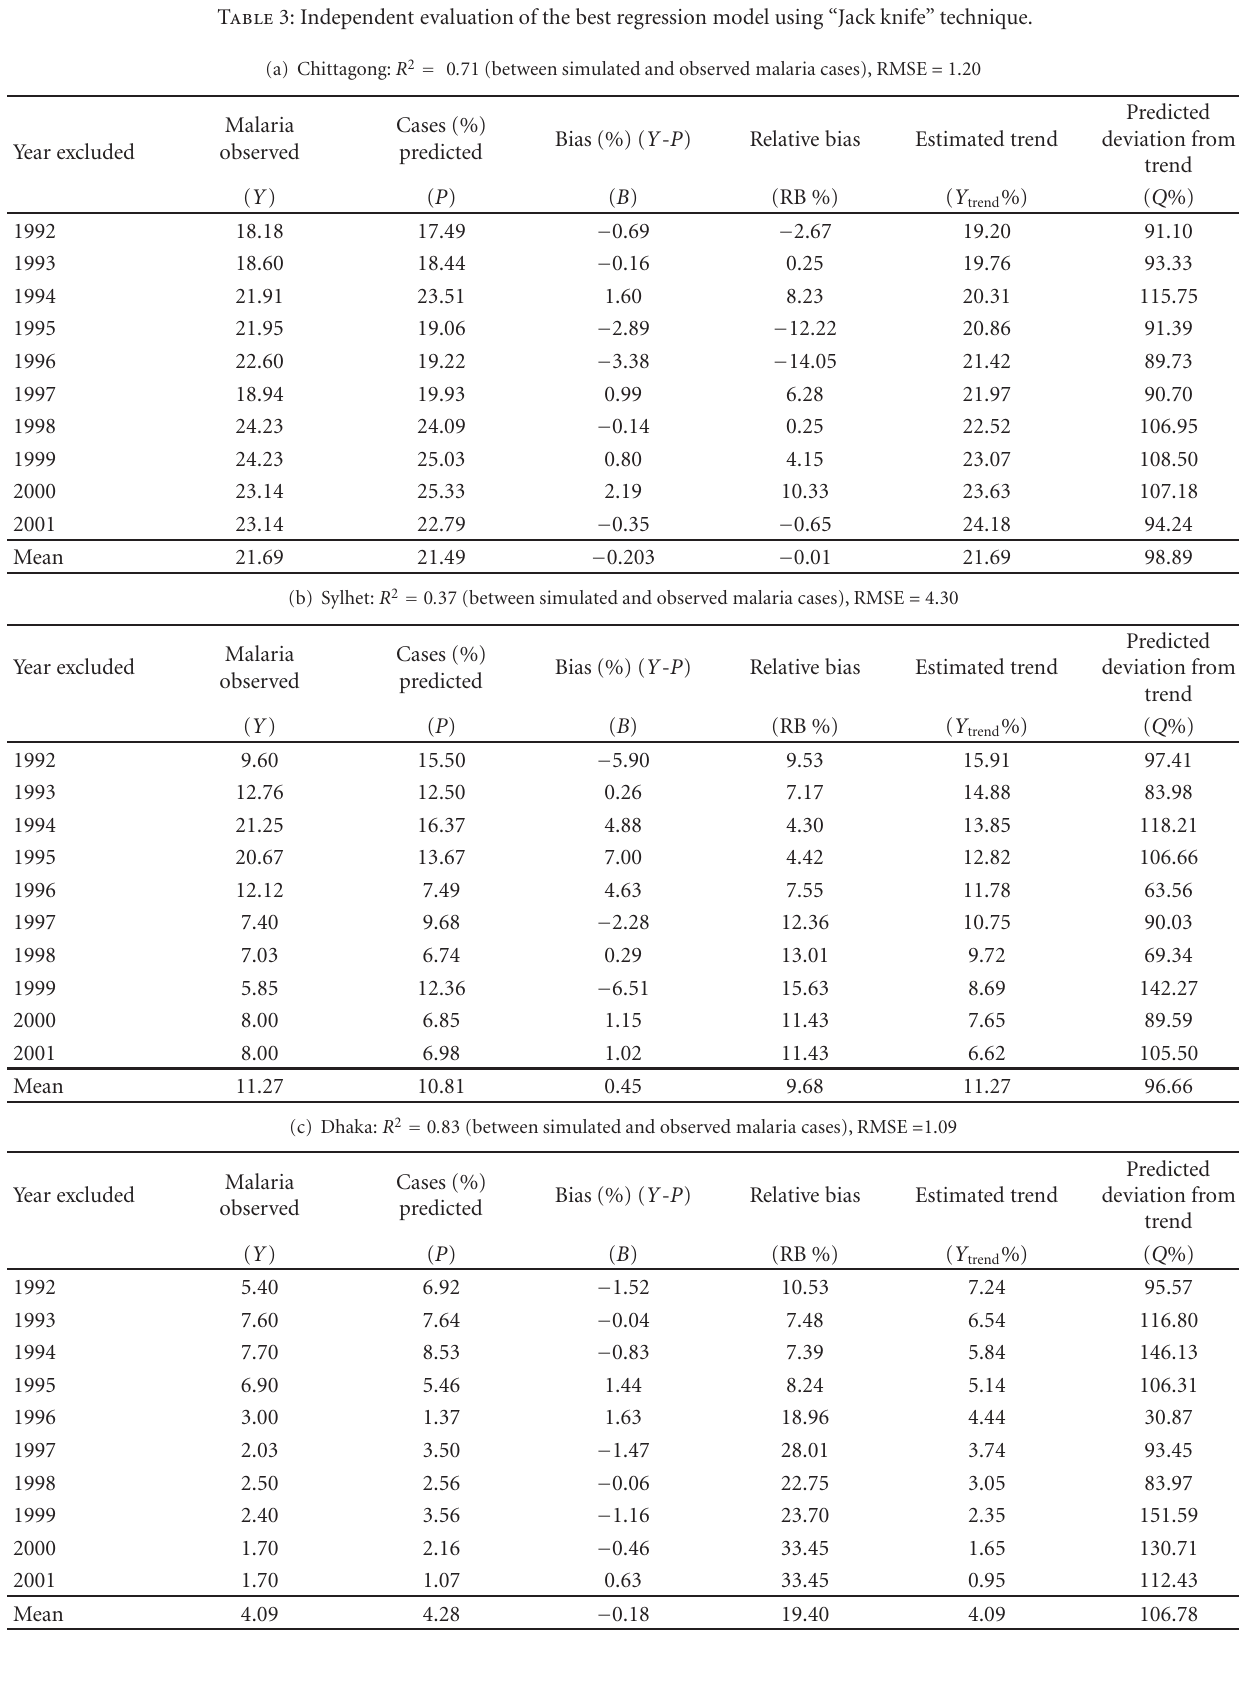
Table 3: Independent evaluation of the best regression model using “Jack knife”